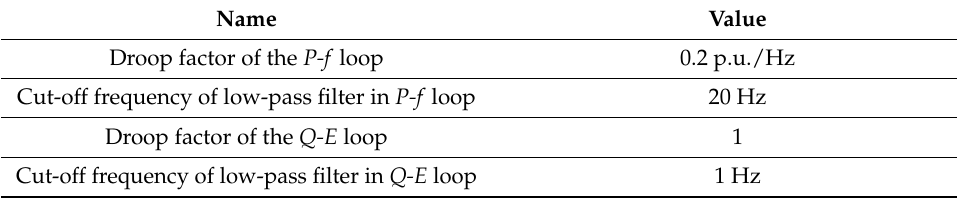
Table 4. Control